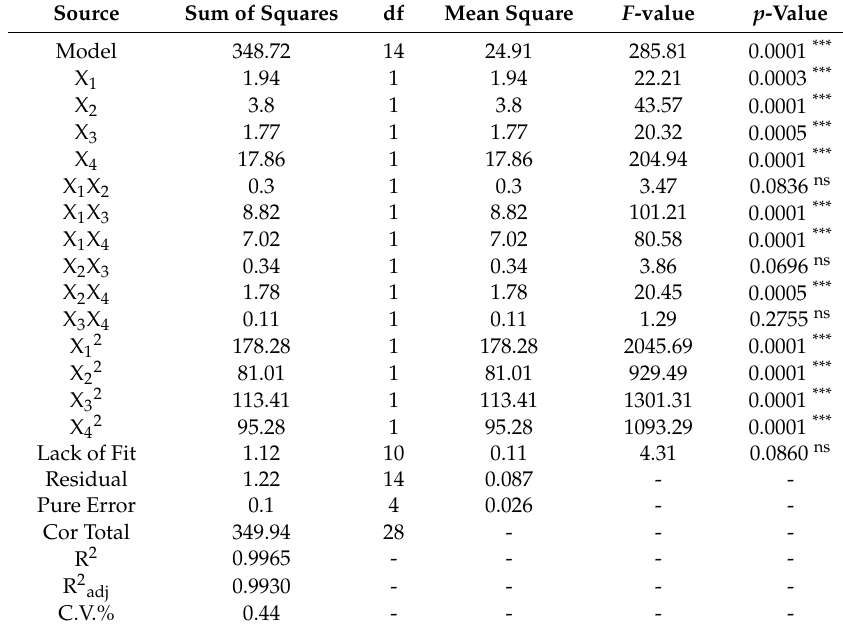
Table 2. ANOVA for response surface quadratic model analysis of extraction